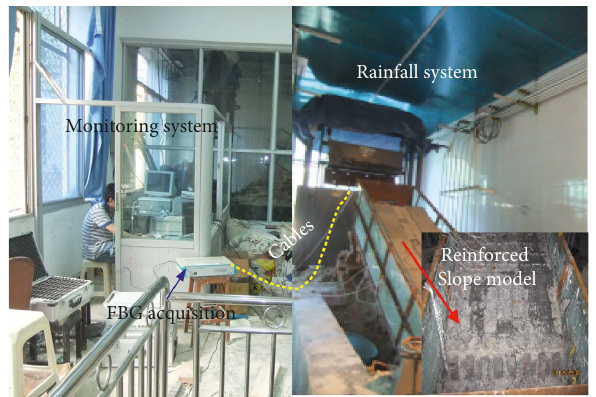
Figure 3: Arrangement of the test